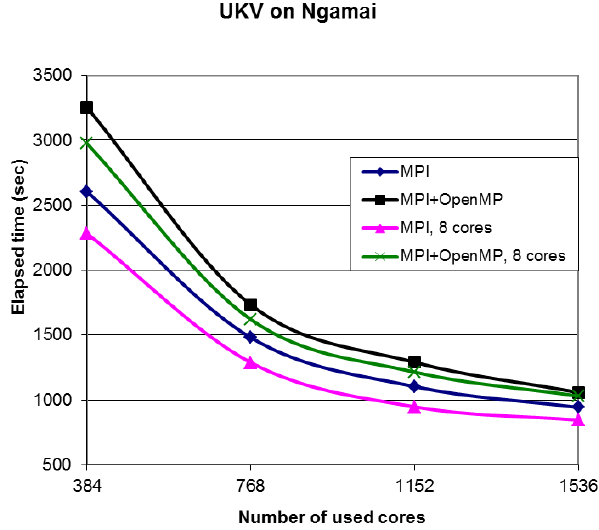
Figure 1. Elapsed times for the UKV model runs on Raijin versus the number of cores actually used in each run.